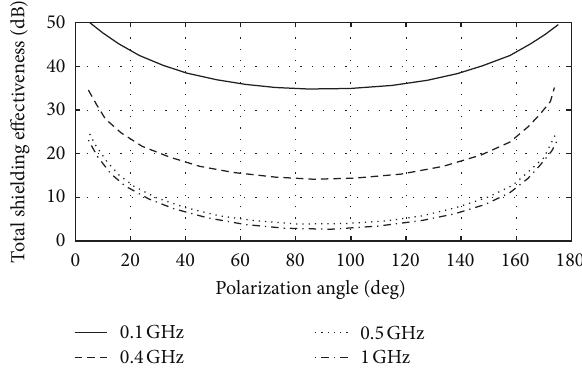
F 6: Shielding effectiveness of a box-shaped enclosure (30 elevation angle of incidence of the plane wave